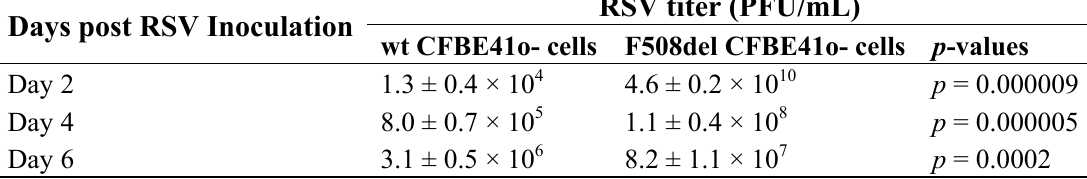
Table 1. Increased RSV replication in F508del CFBE41o- cells. Media from F508del CFTR monolayers demonstrate higher RSV titers at all time points tested. In wt